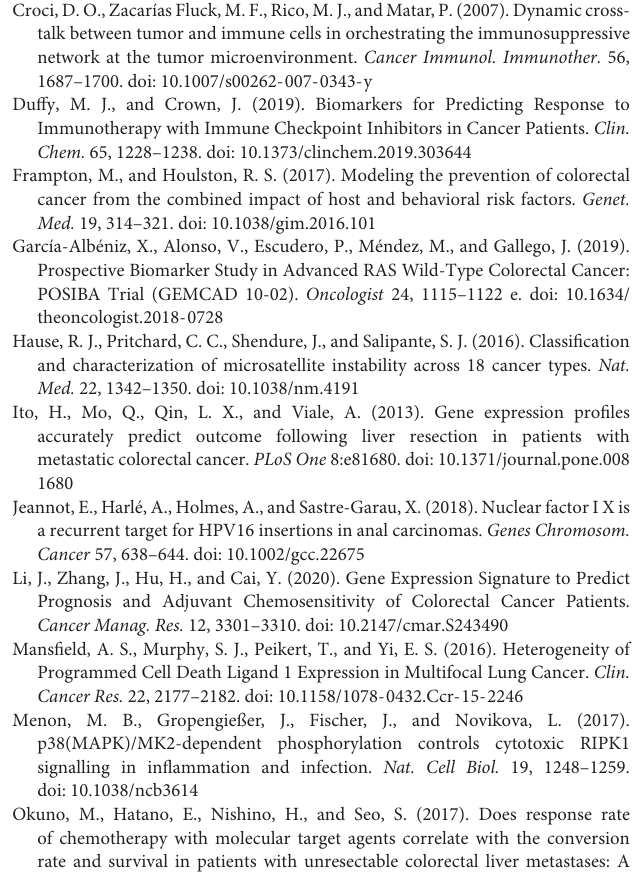
Supplementary Figure 1 | ROC curves of IRG signature and TNM staging in training and validation group. (A) In the training group, the IRG signature yielded an AUC of 0.746, and the AUC of TNM staging was 0.704. (B) The AUC values with IRG signature and TNM staging were 0.622 and 0.609, respectively, in the validation set. In both datasets, the IRG signature showed higher prediction accuracy than traditional TNM staging. Supplementary Table 1 | Univariate Cox regression analysis of IRGs in the Training set. Univariate Cox regression was performed for each IRG regarding survival status to screen for prognostic immune-related genes. The coefficient values, HRs, 95% CIs, and corresponding p- values are given. IRGs with a p < 0.05 were enrolled for further model construction. Supplementary Table 2 | The combination of the IRGs in the training datasets for signature selection. The full-size recombination of the nine IRGs selected by RSFA (2 9 − 1 = 511). The AUC of each combination regarding patient survival was calculated. The six-IRG model with the highest AUC value (0.746) was designated as the prediction panel. Supplementary Table 3 | Functional enrichment analyses using co-expressing genes of selected IRGs. Functional enrichment analyses were used to explore the role of co-expressing genes of the selected